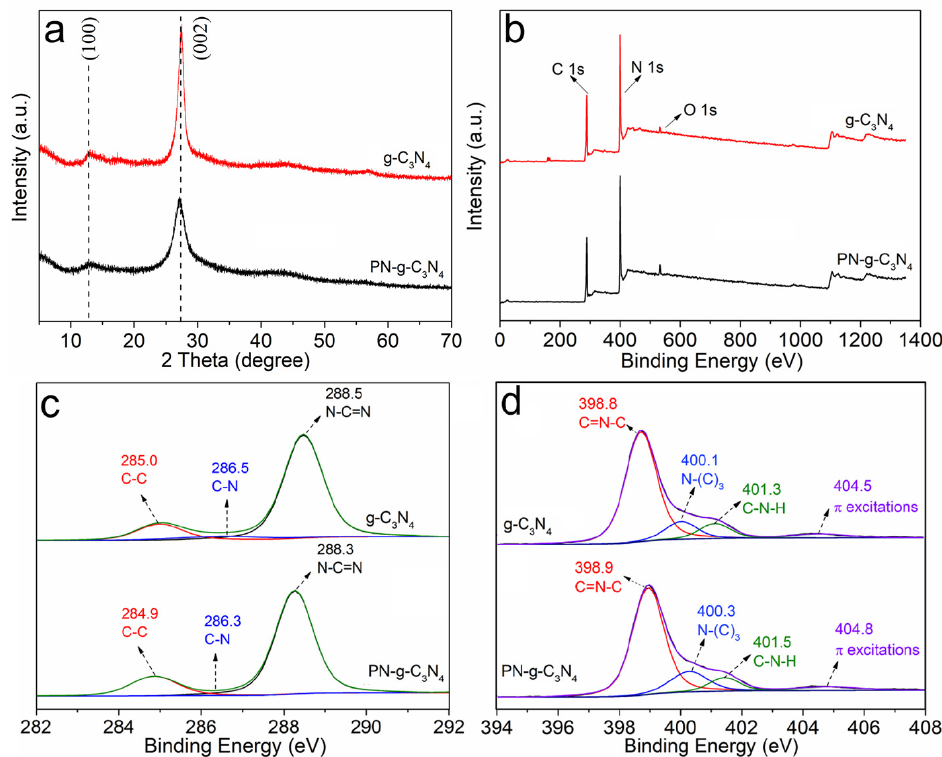
Figure 6. XRD spectra ( a ), XPS survey spectra ( b ), high-resolution C1s ( c ), and N1s ( d ) of g-C 3 N 4 and PN-g-C 3 N 4 .